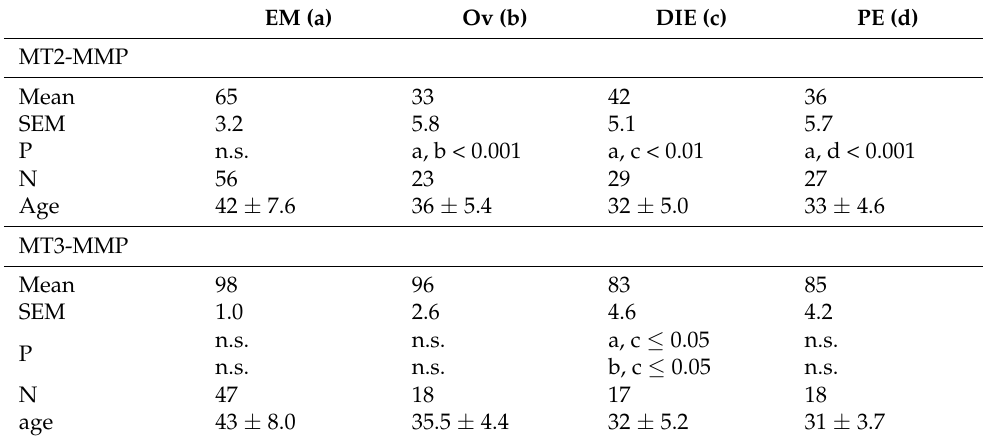
Table 6. Comparison of MT2/3-MMP in eutopic and ectopic endometrium using the percentage of stained